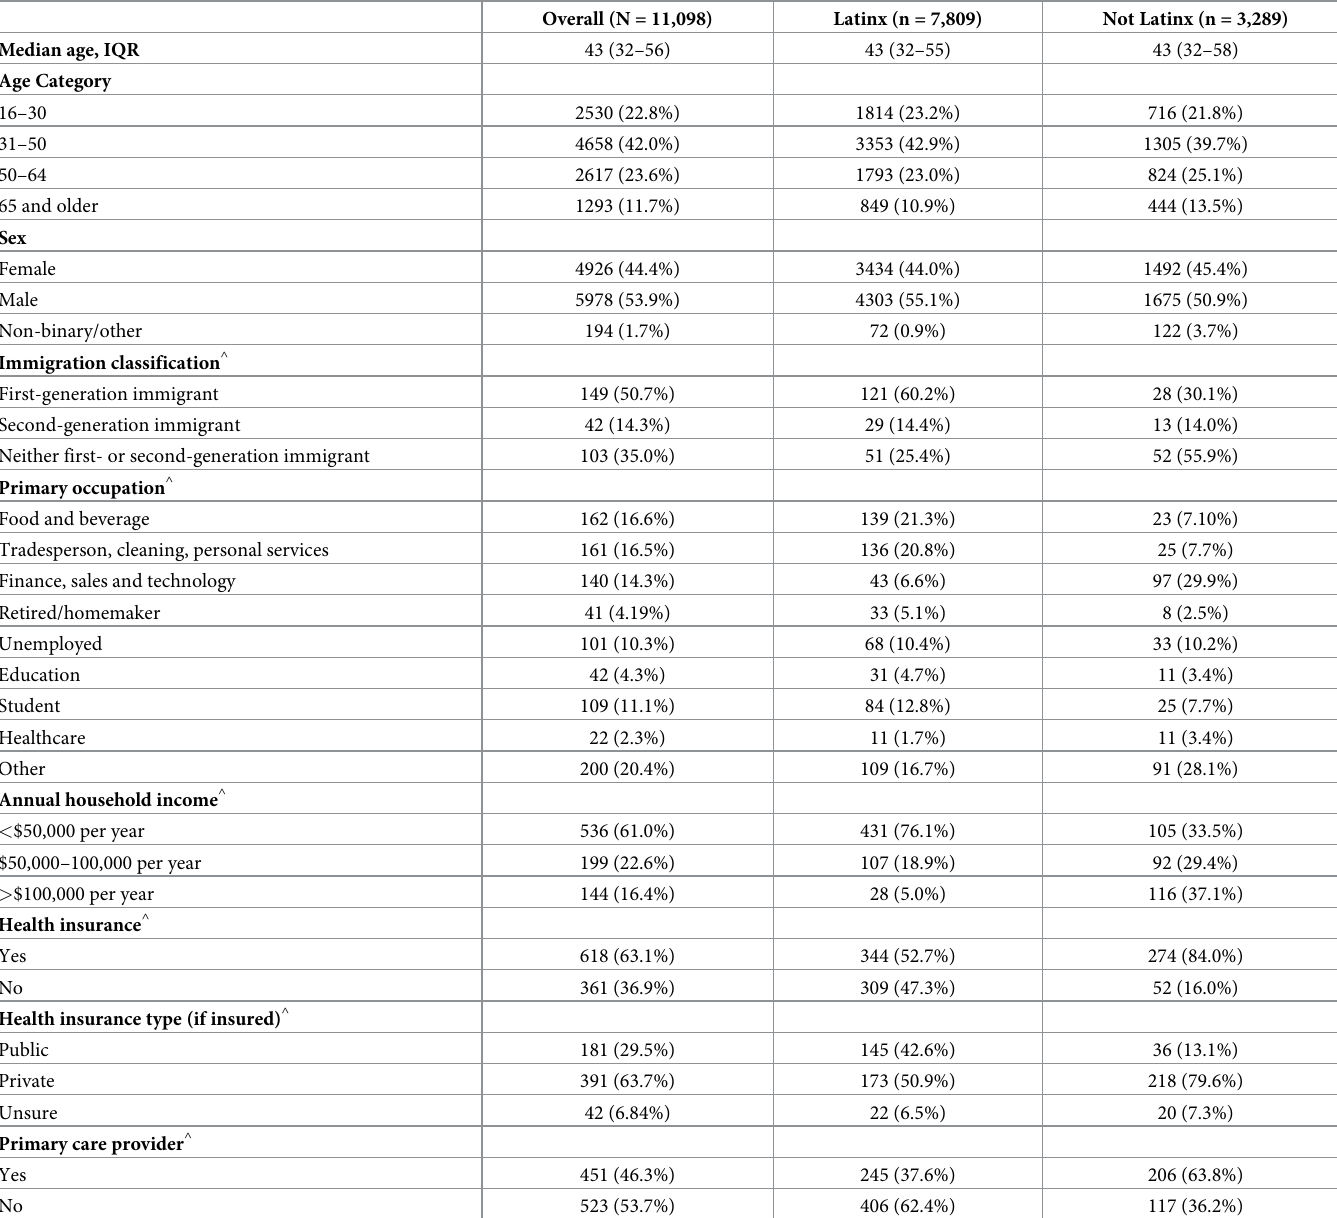
Table 2. Baseline characteristics of clients vaccinated at the Unidos en Salud neighborhood vaccination site, overall and according to